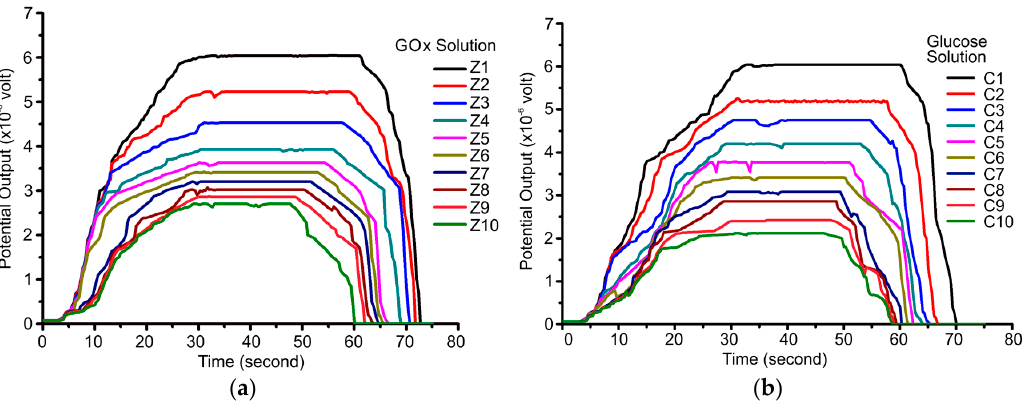
Figure 4. Potential versus time for ( a ) various enzyme concentrations with a glucose concentration of 5.85 M, and ( b ) various glucose concentrations with an enzyme concentration of 2,500,000 units/L. The number of these electrons depends on the amount of hydrogen peroxide. The amount of hydrogen peroxide depends on the glucose concentration. Consequently, the higher the concentration of glucose, the more electrons are generated. This is shown by the amount of potential produced for various glucose concentrations.